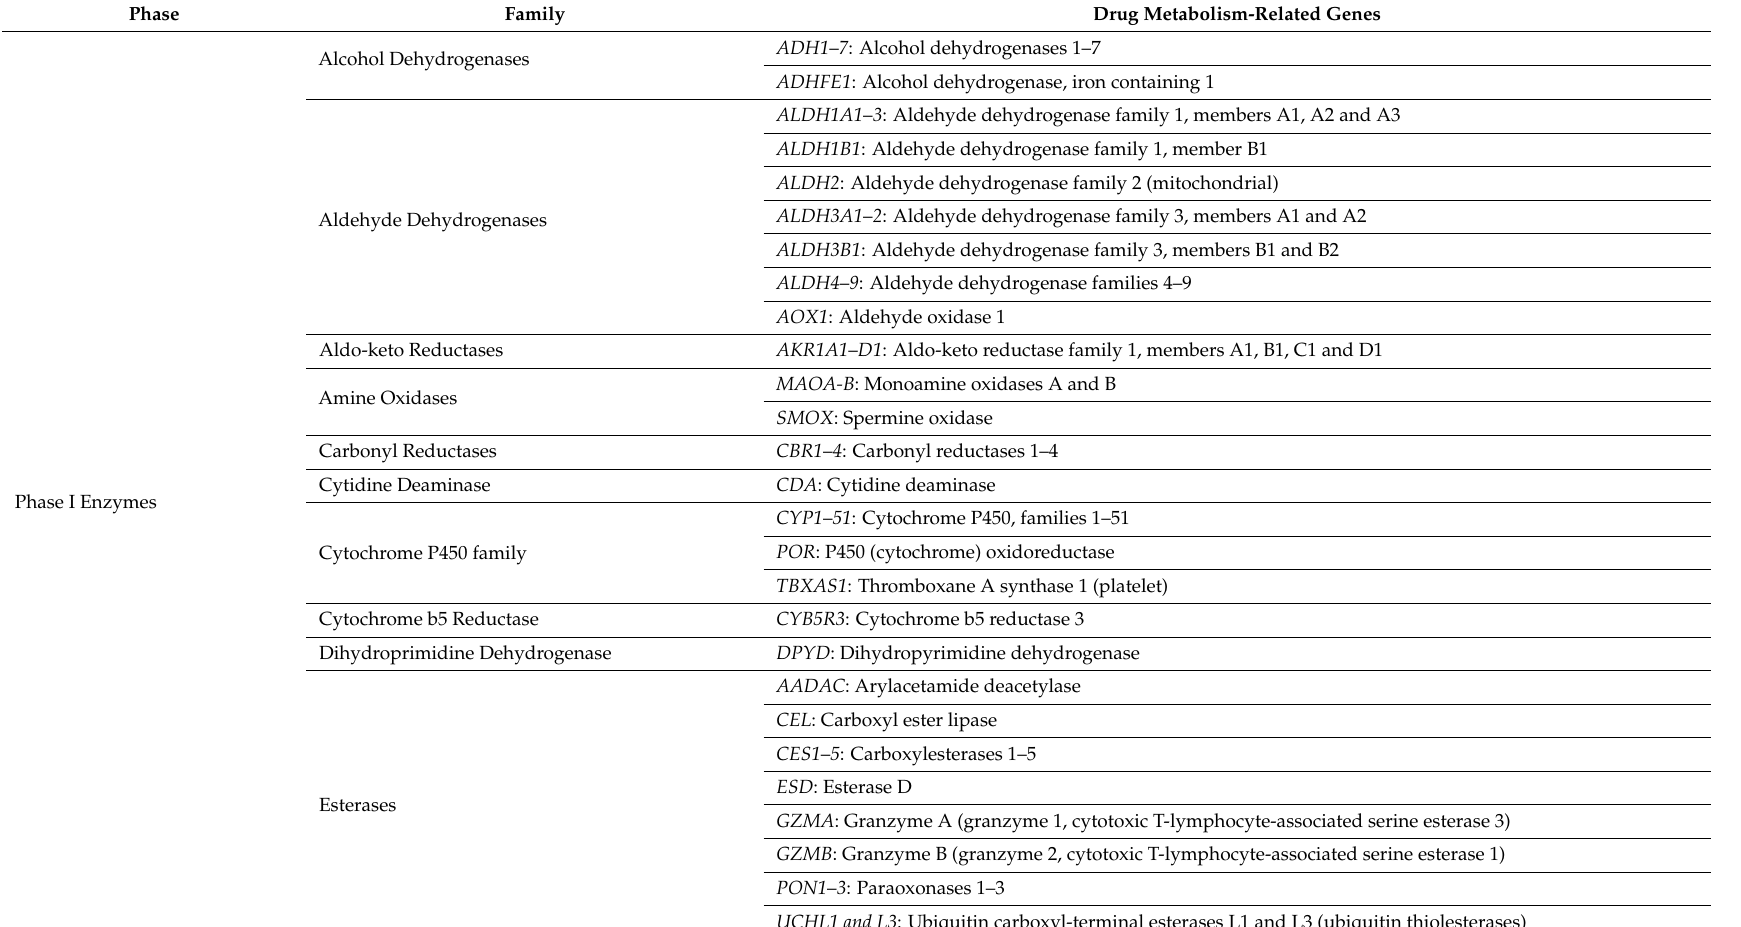
Table 3. Genes involved in drug metabolism and